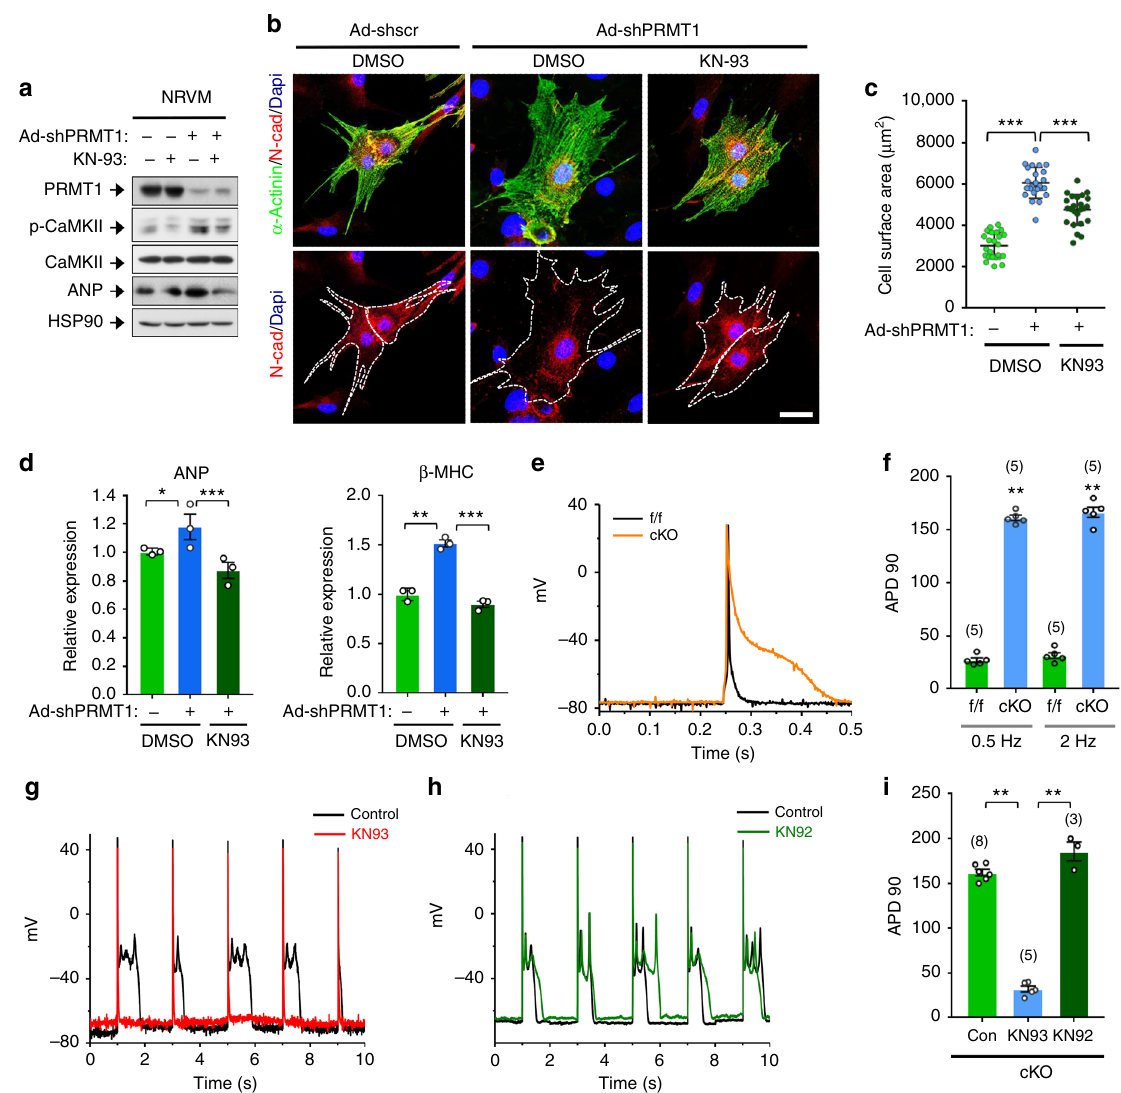
Fig. 5 CaMKII inhibition by KN93 treatment prevents against pathological responses triggered by PRMT1 depletion. a CaMKII protein analysis of control or PRMT1-depleted NRVM cells treated with vehicle or KN93 for 24 h. b Representative images for NRVM cells immunostained with indicated antibodies. Scale bar: 50 μ m. c Quanti fi cation of surface area of cells from similar experiments shown in b . n = 82 (Ad-shscr); n = 75 (Ad-shPRMT1); n = 78 (KN93- treated Ad-shPRMT1). Data represent means± SD. *** P < 0.001, Student ’ s t -test. d qRT-PCR analysis of ANP, and β -MHC levels in control and PRMT1- depleted NRVM cells treated with vehicle or KN93. Data represent means ± SD. * P < 0.05, ** P < 0.01, *** P < 0.001, Student ’ s t -test. e Representative AP traces in ventricular myocytes stimulated at 2 Hz from f/f and cKO mice. f Summary of the time required for 90% repolarization (APD90) showed that AP from cKO mice is dramatically prolonged. The APs were recorded from 7-weeks-old mice. n = 5. Data represent means ± SD. * P < 0.05, ** P < 0.01, Student ’ s t -test. g – h Representative AP traces in ventricular myocytes stimulated at 0.5 Hz from cKO in the presence and absence of KN93 ( g ) or KN92 ( h ). i Bar graph showing the average APD90 of ventricular myocytes stimulated at 0.5 Hz from cKO mice in the absence and presence of KN93 or KN92. Data represent means ± SEM. ** P < 0.01, Student ’ s t